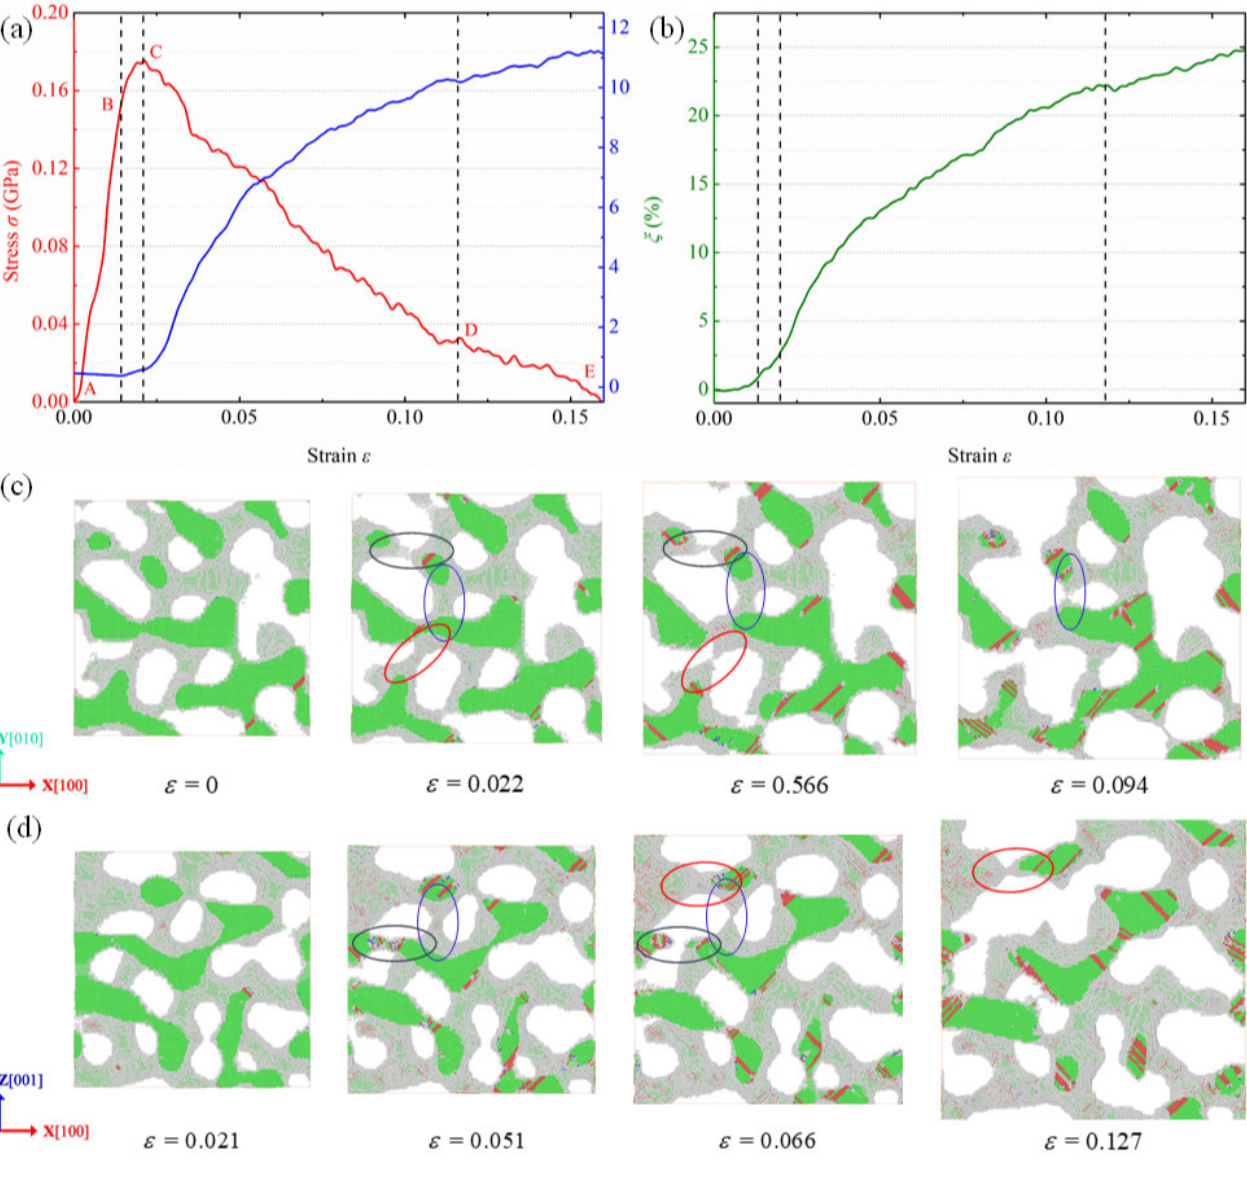
Figure 5. Variations of ( a ) stress along the X [100] direction (left, red), and HCP atom fraction η (left, blue), and ( b ) surface atom fraction ξ of NPG in triaxial tension with the applied strain. ( c , d ) Microstructure evolution of NPG in triaxial tension with different slices: ( c ) a slice between z = 12.5 nm and z = 17.5 nm, and ( d ) a slice between y = 5.8 nm and y = 10.8